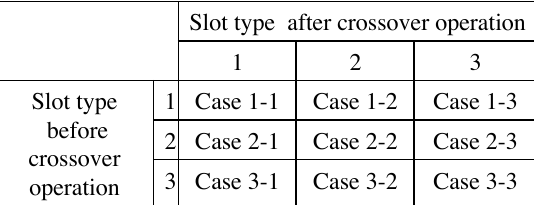
Figure 10. Cases of repairing genes after crossover slot type